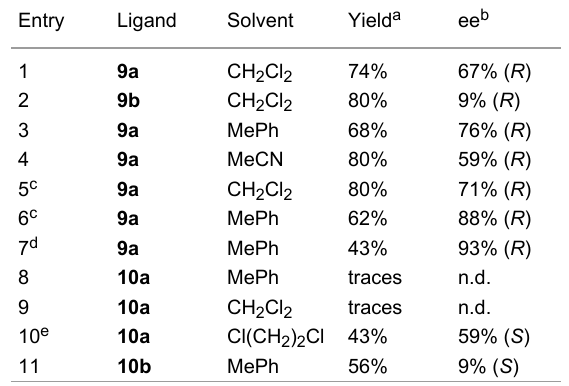
Table 1: Pd-catalyzed allylic alkylation using ligands 9 and 10